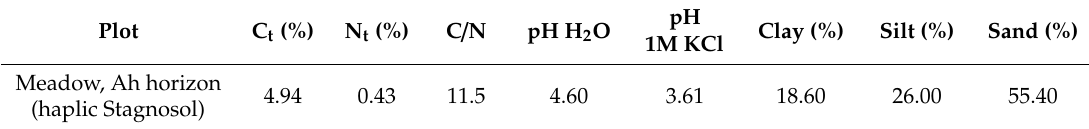
Table 1. Selected physical and chemical properties of the tested soils.